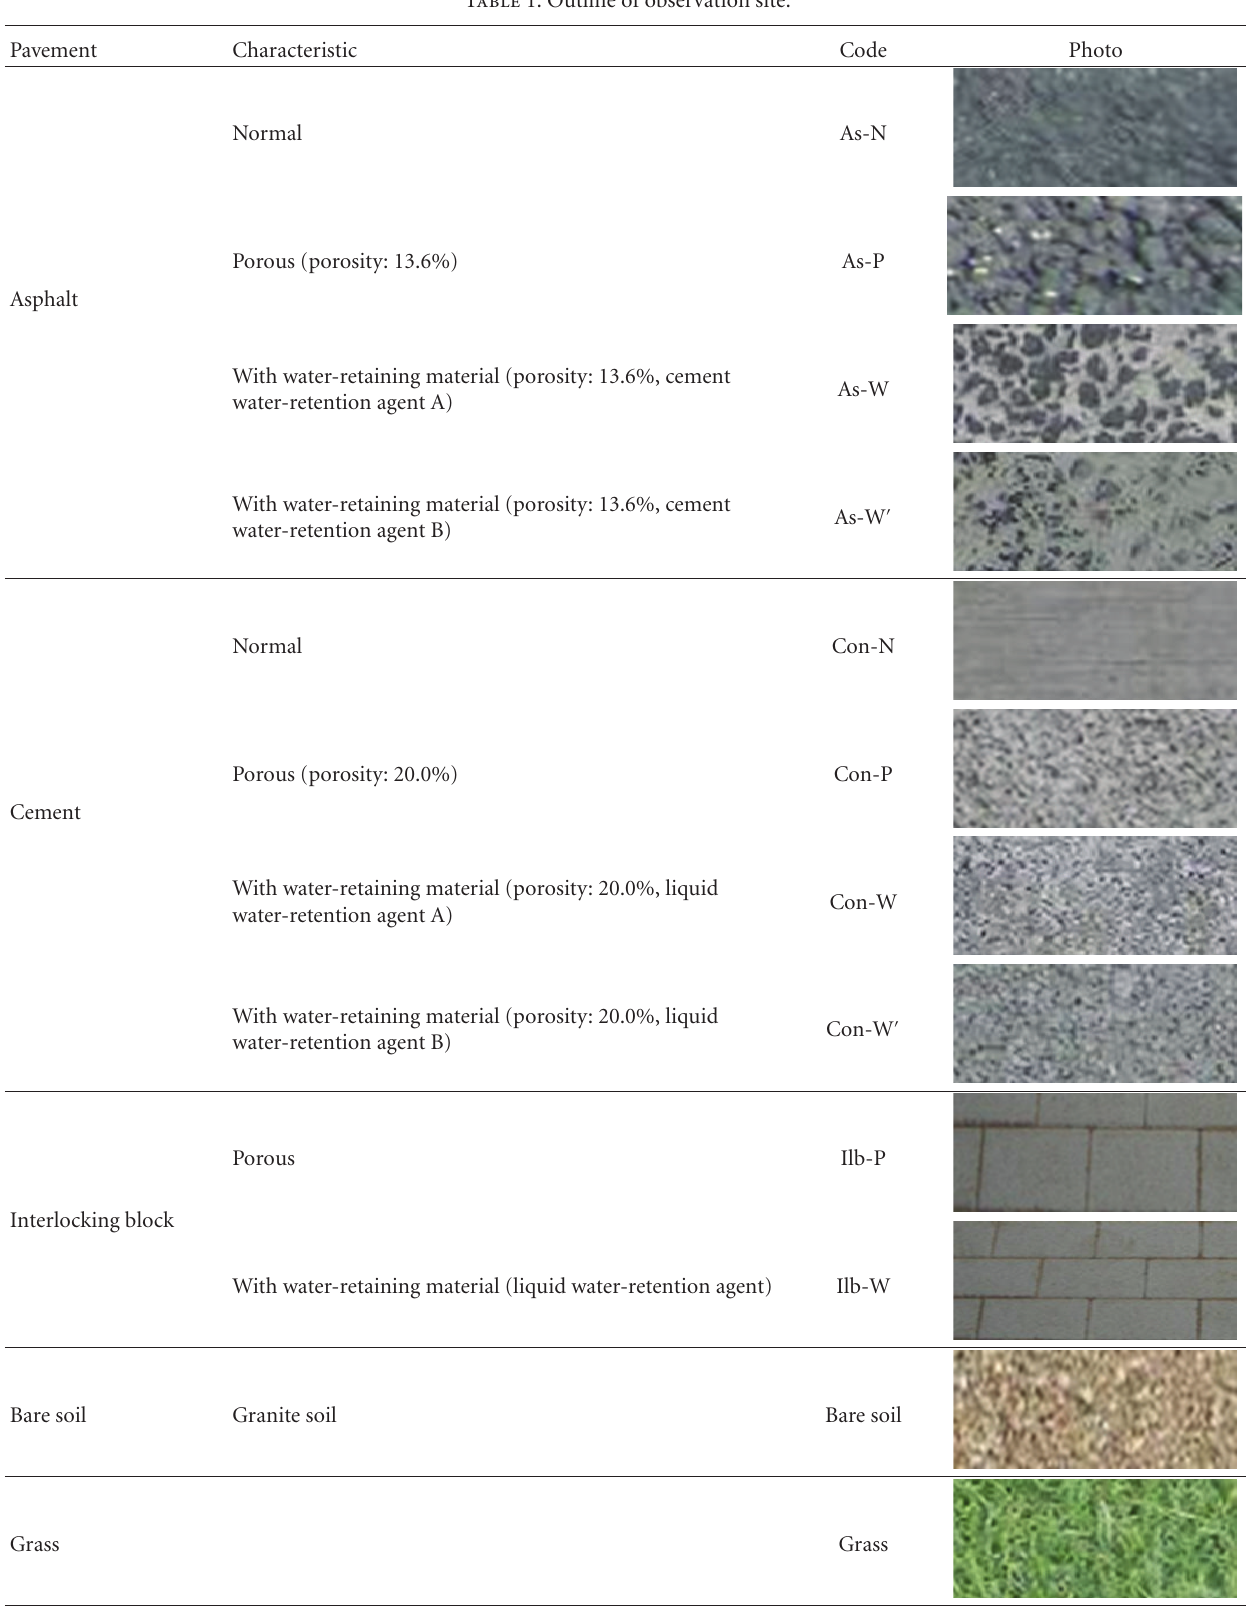
Table 1: Outline of observation